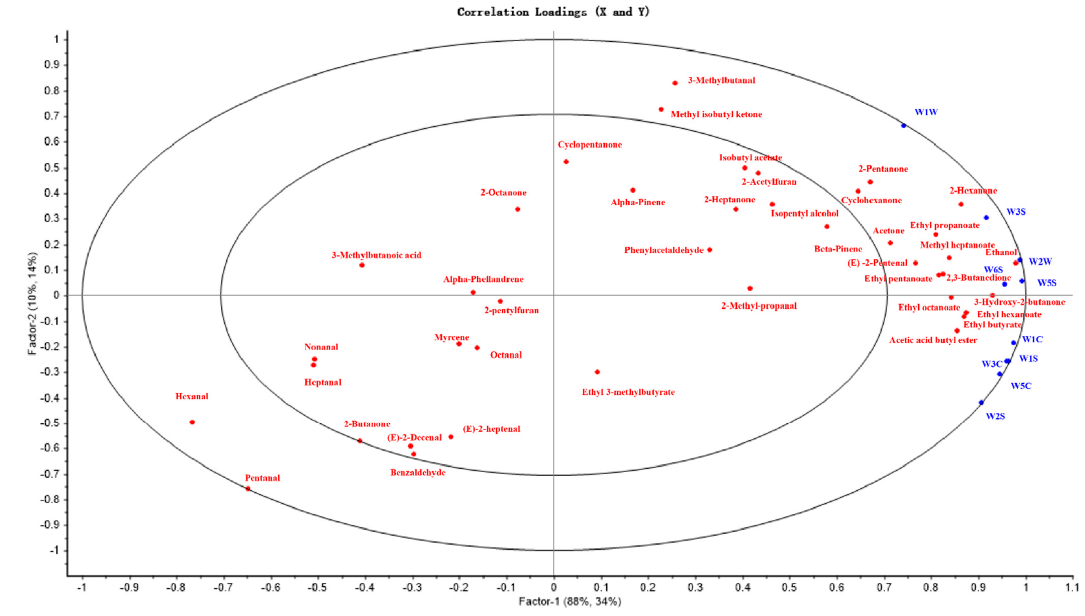
Figure 6. Correlation of sensors and VOCs. Table 4. The taste